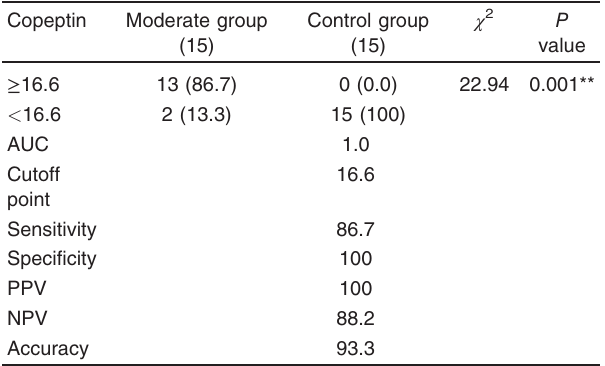
AUC, and area under the curve; NPV, negative predictive value; PPV, positive predictive value. **Highly significan. Table 14 Validity of copeptin as a predictor of disease among patients with severe bronchial asthma